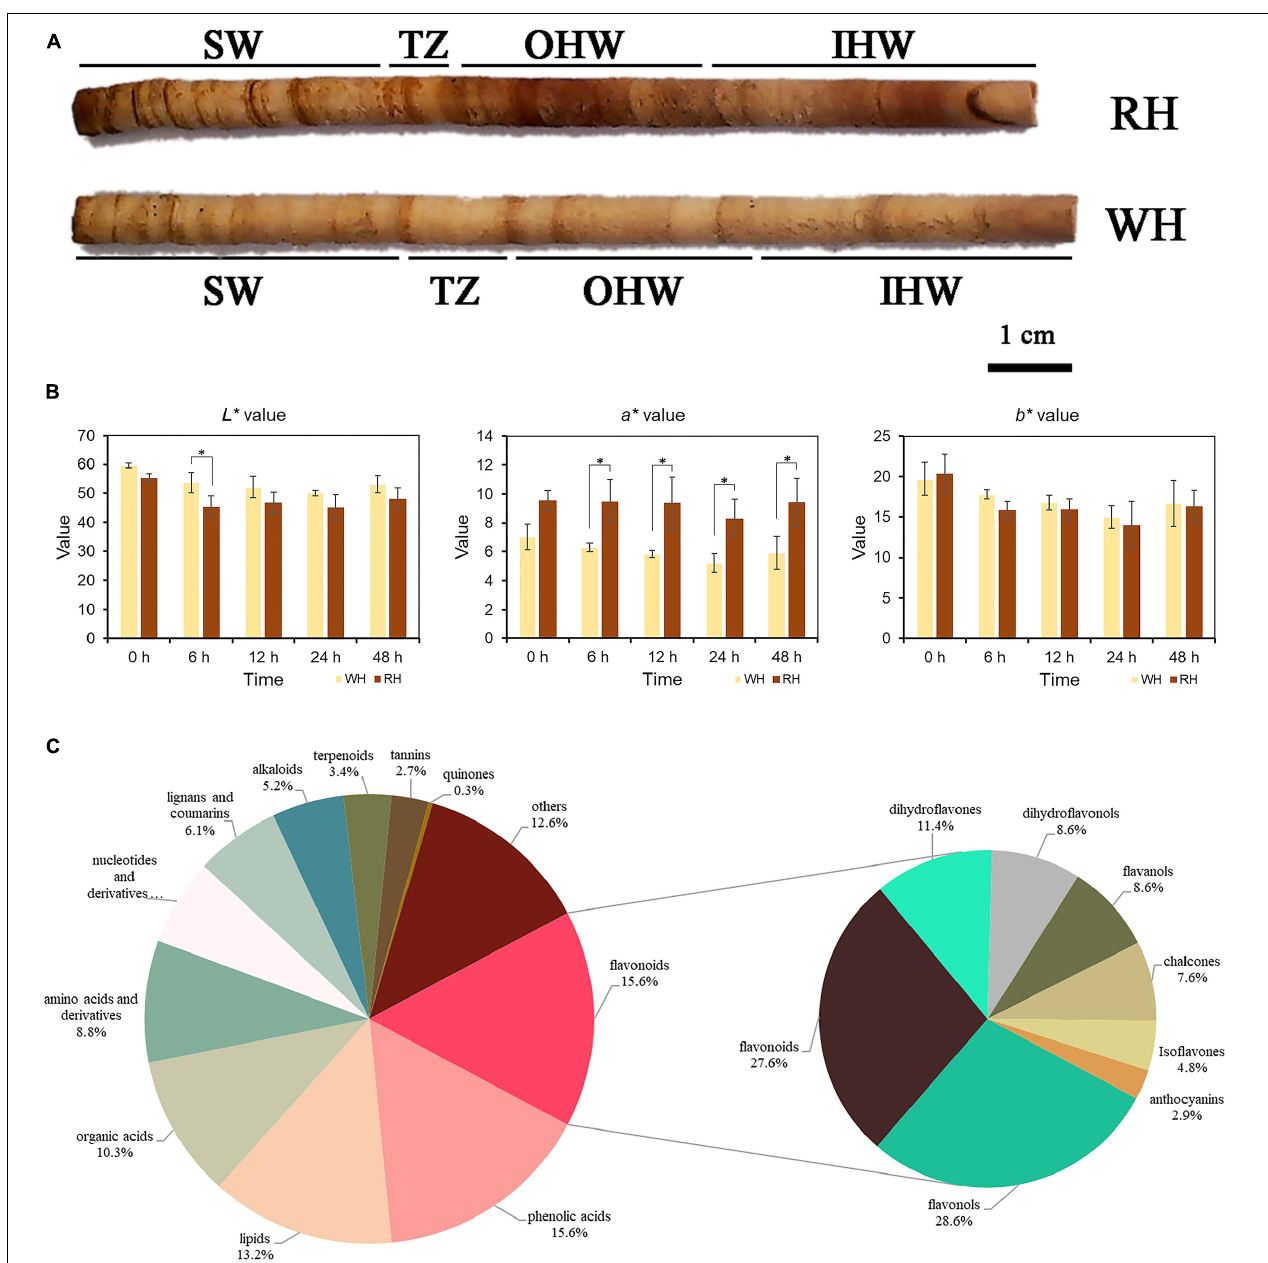
FIGURE 1 | (A) A core of white-heart and red-heart Chinese fir wood, showing red-colored tissue (heartwood) and light-yellow tissue (sapwood), were divided into sapwood (SW), transition zone (TZ), outer heartwood (OHW), and inner heartwood (IHW) in the present study. The left side was closer to the pith. (B) L*a*b* values of white-heart and red-heart Chinese fir core after 0, 6, 12, 24, and 48 h in vitro . Data represent mean values ± SE of three independent measurements. ∗ Indicates a significant difference between RH and WH at p -values < 0.05 by Duncan’s test. (C) Types and proportions of differential secondary metabolites among SW, TZ, OHW, and IHW in white-heart and red-heart Chinese